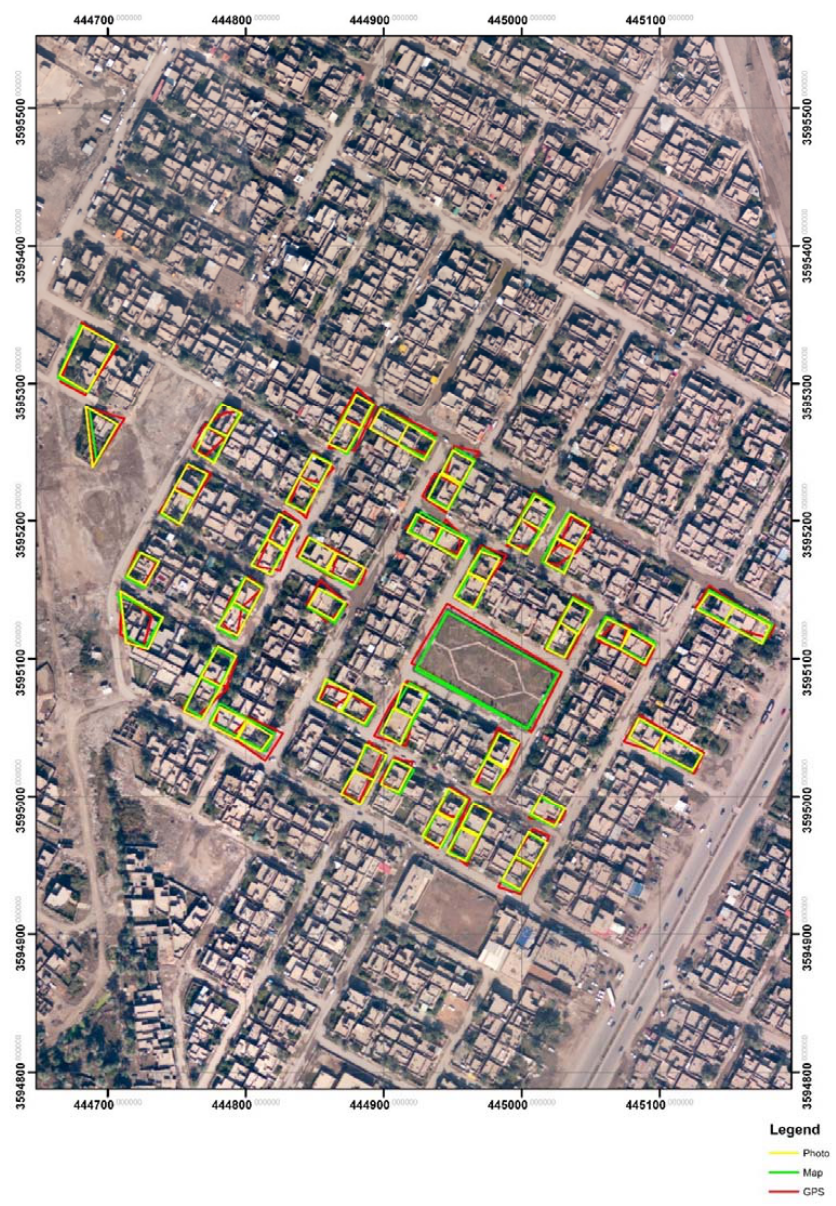
Figure 3. Moharbeen urban area, Al-Hillah. VGI-defined land parcel boundaries using three methods of delineation.